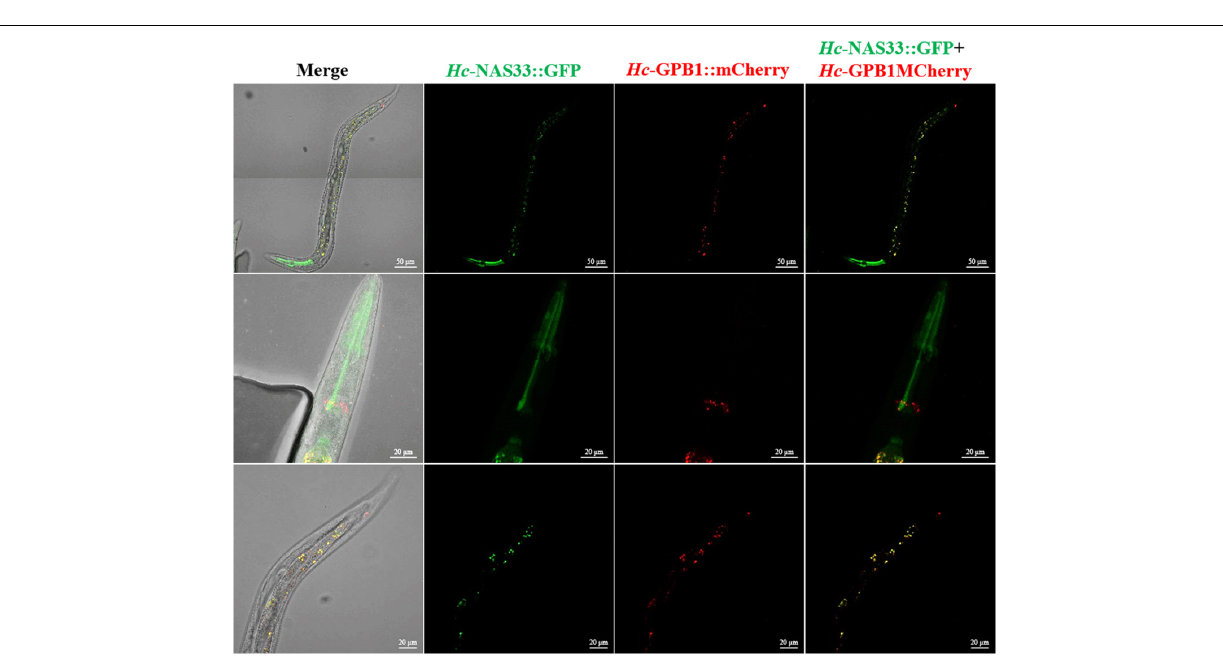
Frontiers in Cell and Developmental Biology |